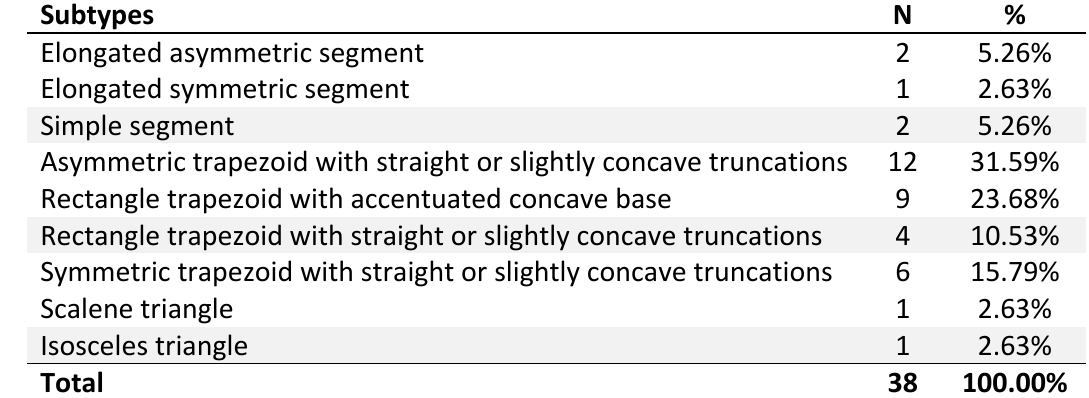
Table 3. Geometric armatures subtypes from Lapa da